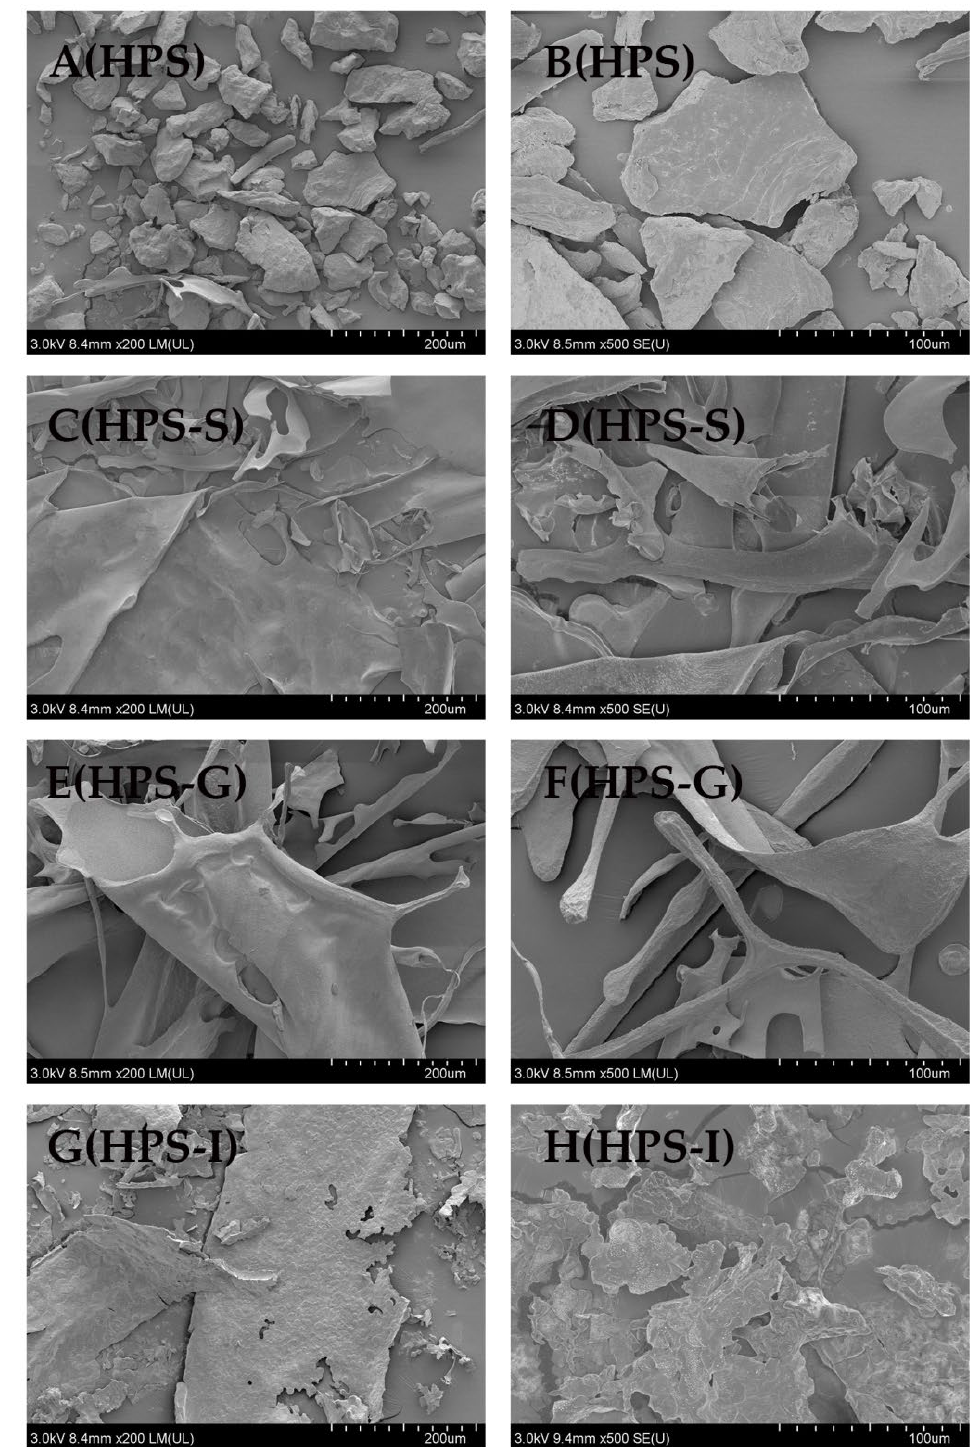
Figure 3. Comparison of scanning electron microscope (SEM) images of different digested samples